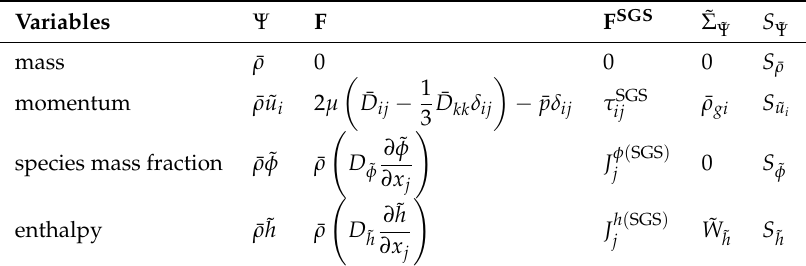
Table 1. Specification of quantities appearing in the filtered transport